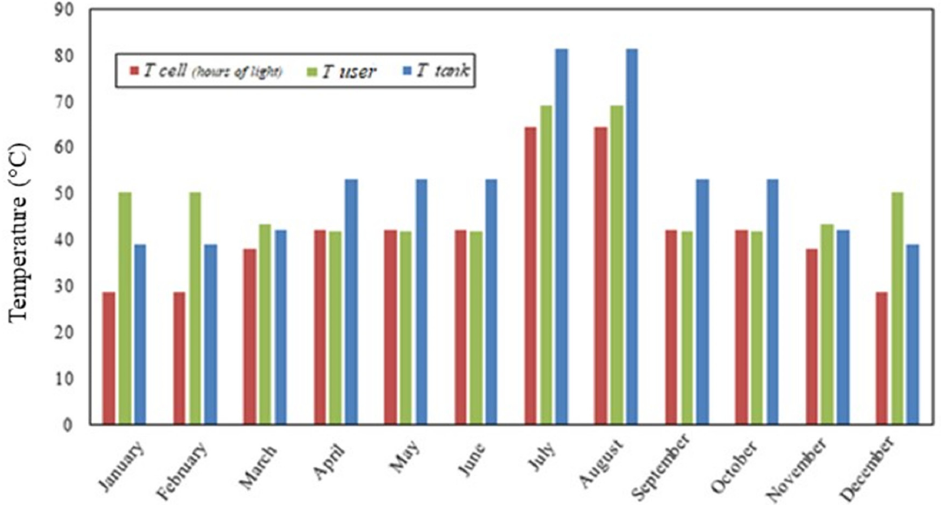
Figure 14. Monthly values of TJ cell temperature (hours of light), temperature of user and tank average temperature.